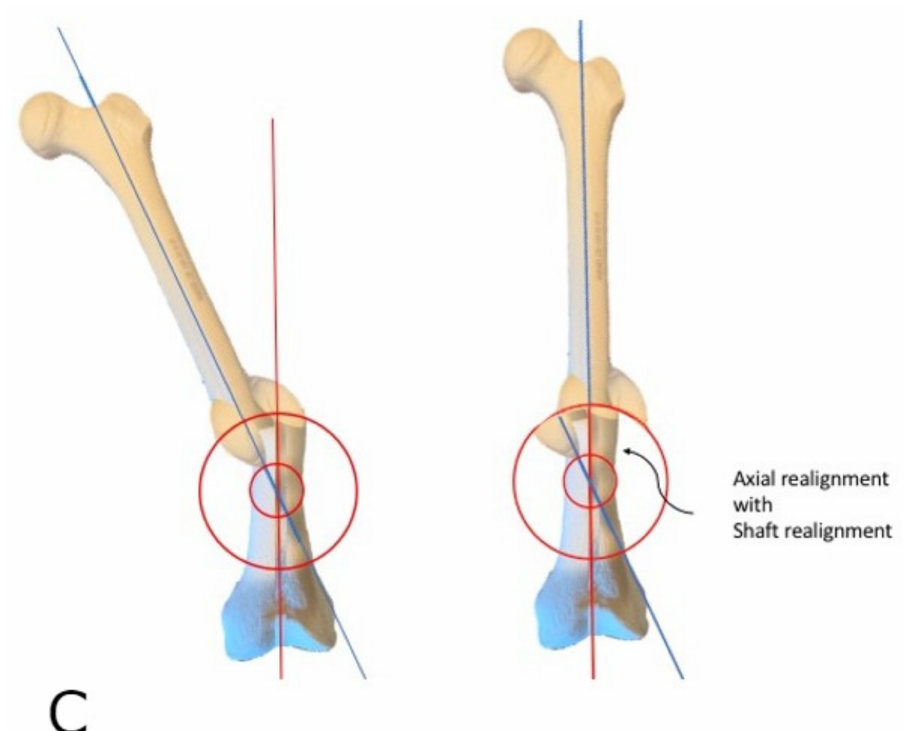
Figure 5. Translational deformity. When the calculation of CORA demonstrates that the intersection of the proximal and distal diaphyseal axes do not meet at the center of the deformity, this is due to translation in addition to angulation. The focal dome osteotomy can correct both the translation and angulation when the radius is centered at the CORA and not centered at the deformity. When the radius chosen for the focal dome is as small as possible, the axis is corrected, and the translation is also corrected, but the diaphysis may have some induced focal diaphyseal deformity that could prevent the use of an intramedullary implant. In contrast, when using the same CORA but enlarging the radius to reach the center of the deformity, the angular deformity and translation will correct while minimizing the local diaphyseal deformity. This is desirable for implementing intramedullary implants. ( A ) CORA demonstrates angulation, as well as translation. Two radii are shown for potential focal dome corrections. ( B ) A small radius osteotomy results in axial and translational correction, while the diaphyseal deformity that results may prevent the use of intramedullary implants. ( C ) A large radius osteotomy that coincides with the center of the deformity corrects the axis and translation while minimizing diaphyseal deformity, enabling intramedullary